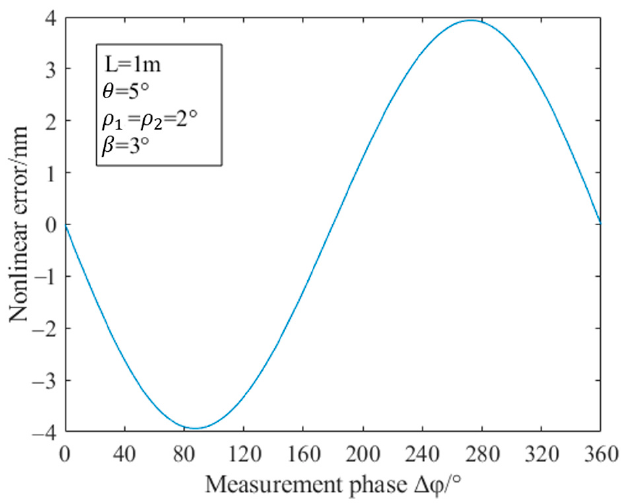
Figure 7. Relationship between the nonlinear error and the measurement phase under theoretical conditions.